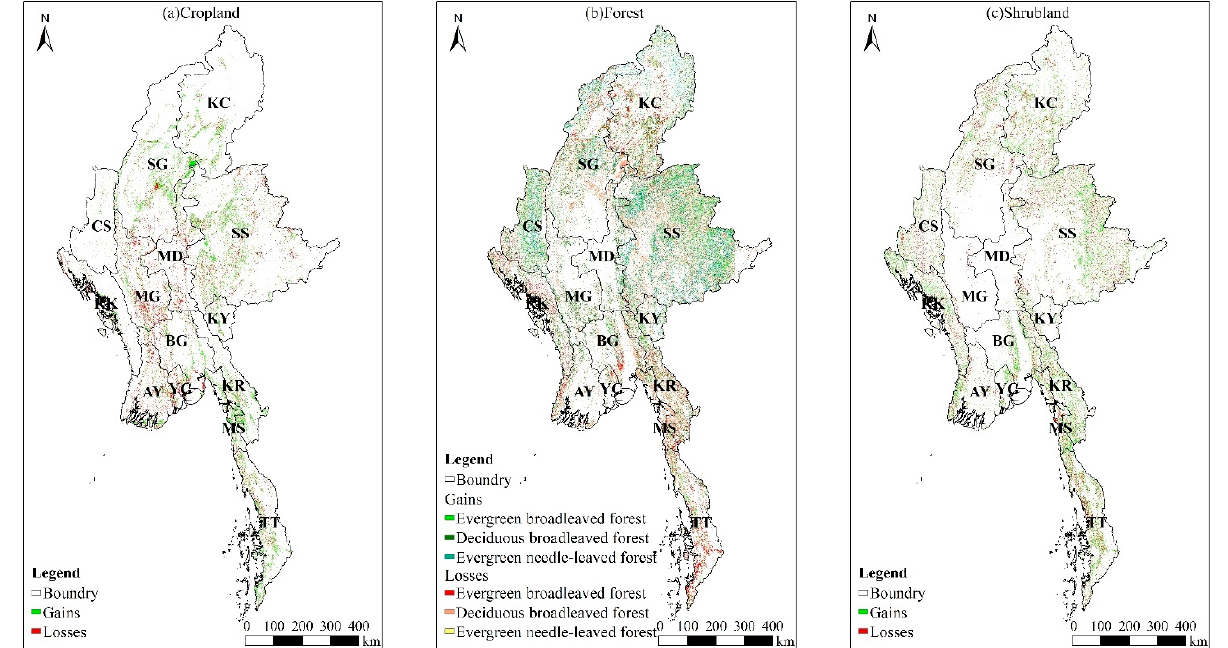
Figure 5. Spatial distributions of different LUC gains/losses from 2000 to 2020.